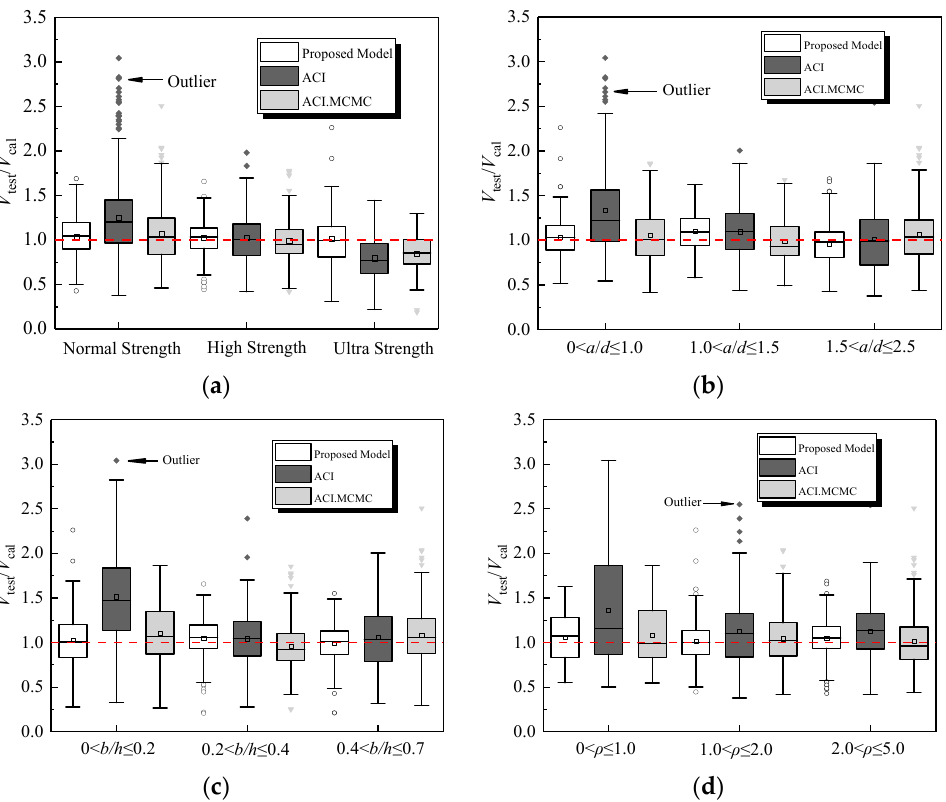
Figure 6. The boxplots of the experiment-prediction ratios. ( a ) f c ′ /MPa . ( b ) a / d . ( c ) b / h . ( d ) ρ /% . The boxplots of the bias of the proposed model, ACI 318-14, and the modified prob- abilistic model were made for comparison. As shown in Figure 6a, the ACI 318-14 tended to underestimate the shear strengths of normal-strength members and overestimate ultra- strength members. The experiment-prediction ratio decreased as concrete strength in- creased. Similarly, the ACI 318-14 model tended to underestimate the shear strengths for 0 < ρ ≤ 1.0 members and had great discreteness. Figure 6c depicts the ACI 318-14, which had a very large scatter of prediction for all ranges of b / h , and the bias was not uniform. The modified probabilistic model based on ACI 318-14 effectively corrected these bi- ases and allowed for more consistent performance over the considered ranges. This may be due to the fact that the bias correction term indirectly considers the effect of f c ′ , b / h , and ρ , etc. As for ultra-strength and 0 < b / h < 0.2 members, the proposed model still had great variability (i.e., CoVs > 0.25), which probably results from uniform distributions of param- eters in the database. It is concluded that these boxplots confirmed that the proposed model performed uniformly well over the entire ranges of the selected key parameters.